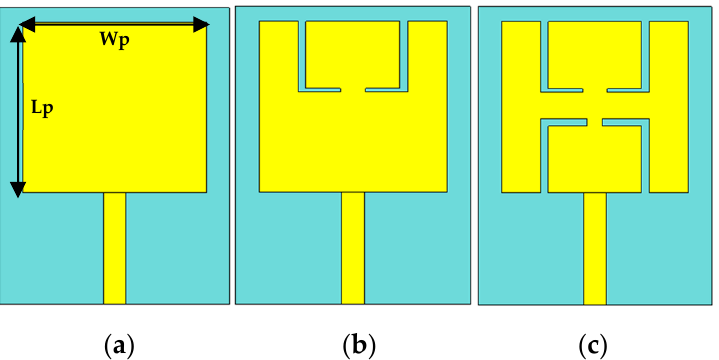
Figure 2. S 11 of the designed dual-band antenna.